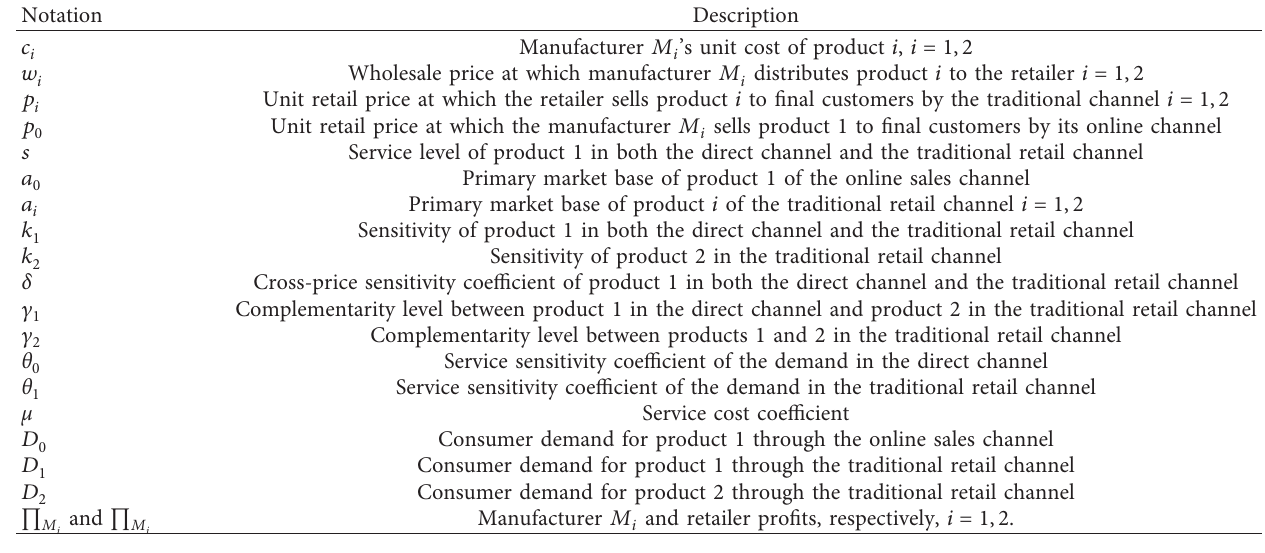
Table 1: Notations and corresponding